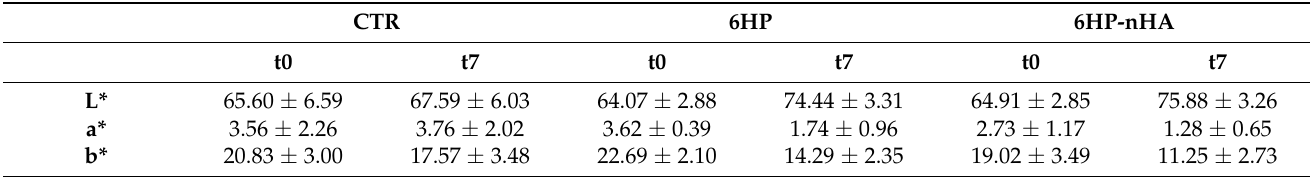
Table 2. CIELAB parameters of Control Group (CTR), 6% hydrogen peroxide (6HP) and 6% hydrogen peroxide and nano-hydroxyapatite (6HP- nHA) at the baseline (t0) and after 7 days after bleaching treatment